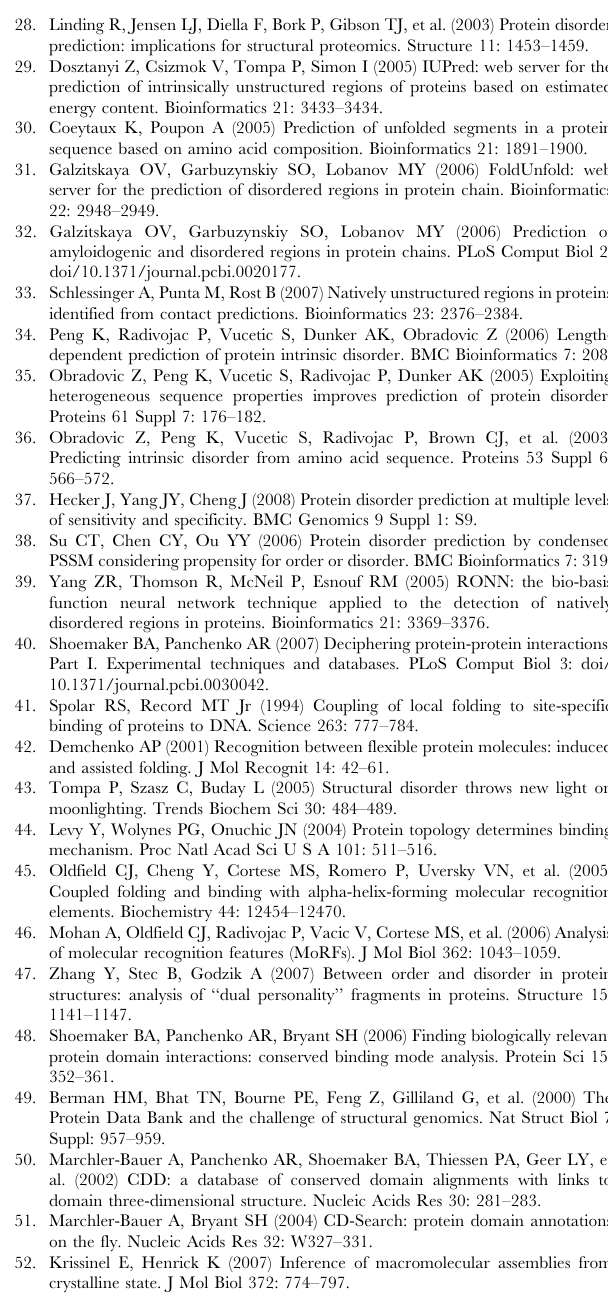
Table S2 Comparison of different disorder prediction methods for proteins from Table